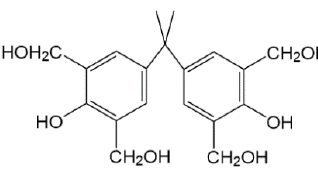
Figure 9. Molecular structural formula of hydroxymethyl (-CH 2 OH) in a novel phenolic resin crosslinking agent.